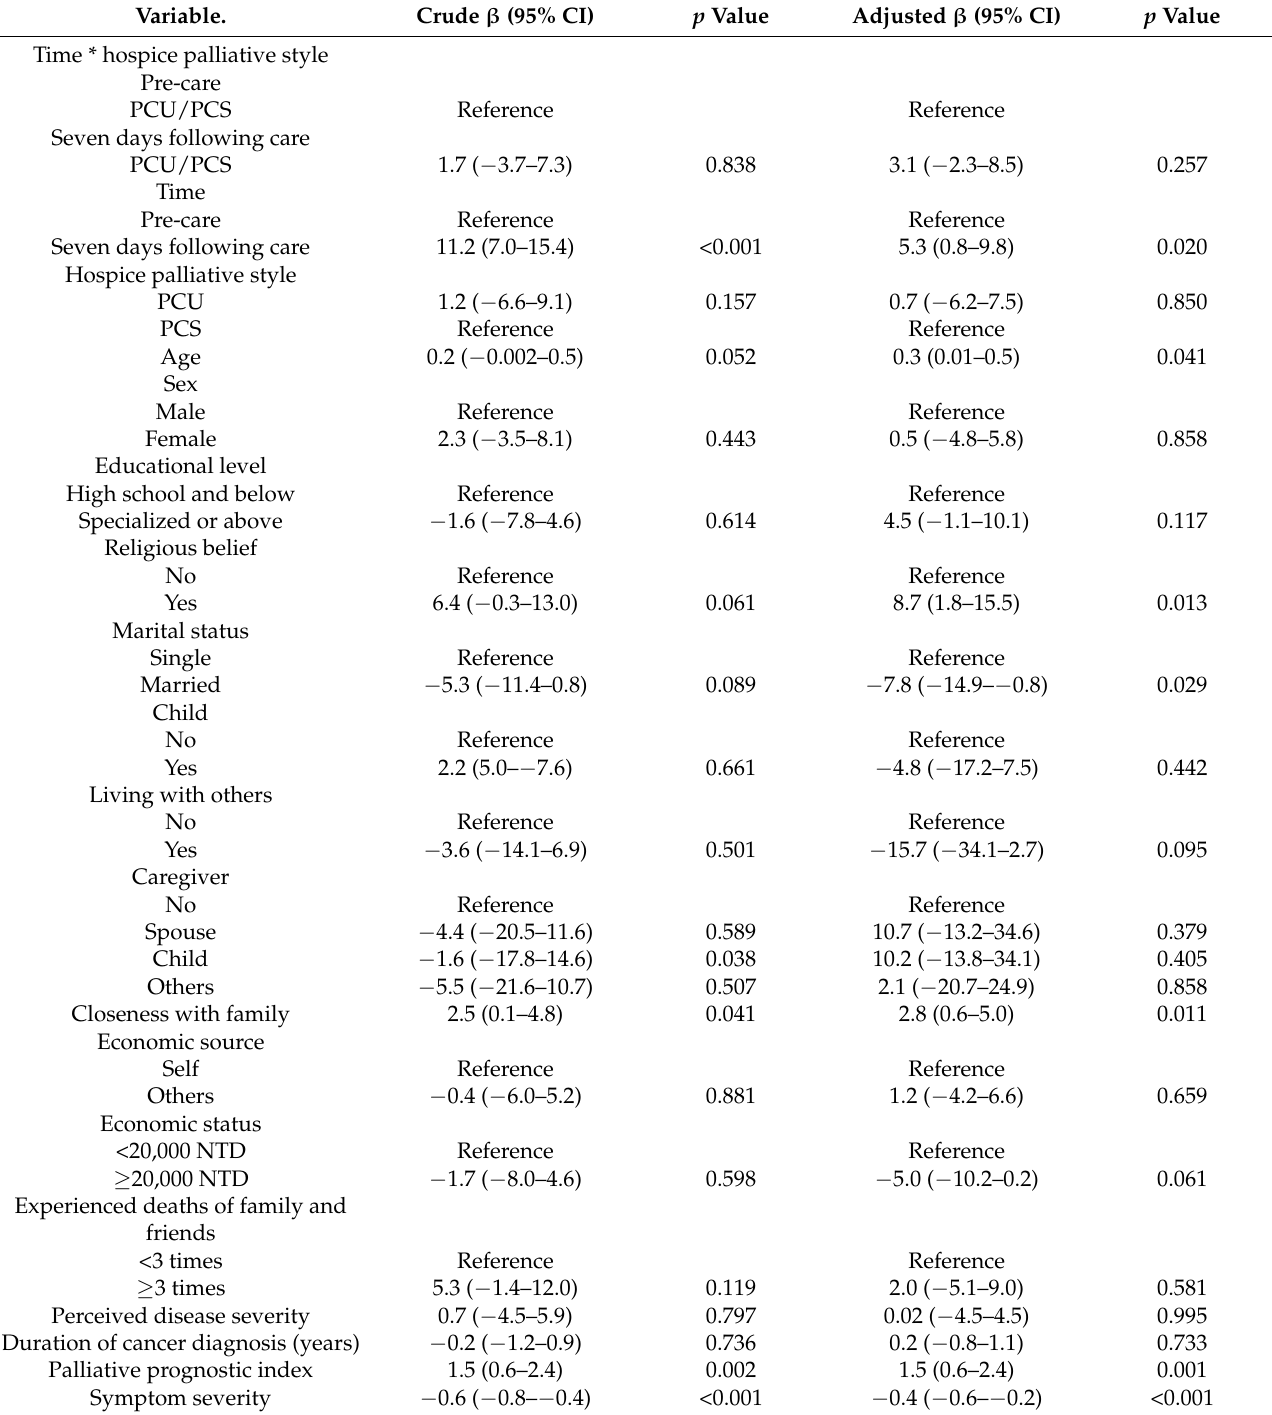
Table 3. Predictors of CoQoLo level of terminally ill cancer patients pre- and seven days following PCU and PCS ( n = 90). Variable. Crude β (95% CI) p Value Adjusted β (95% CI) p